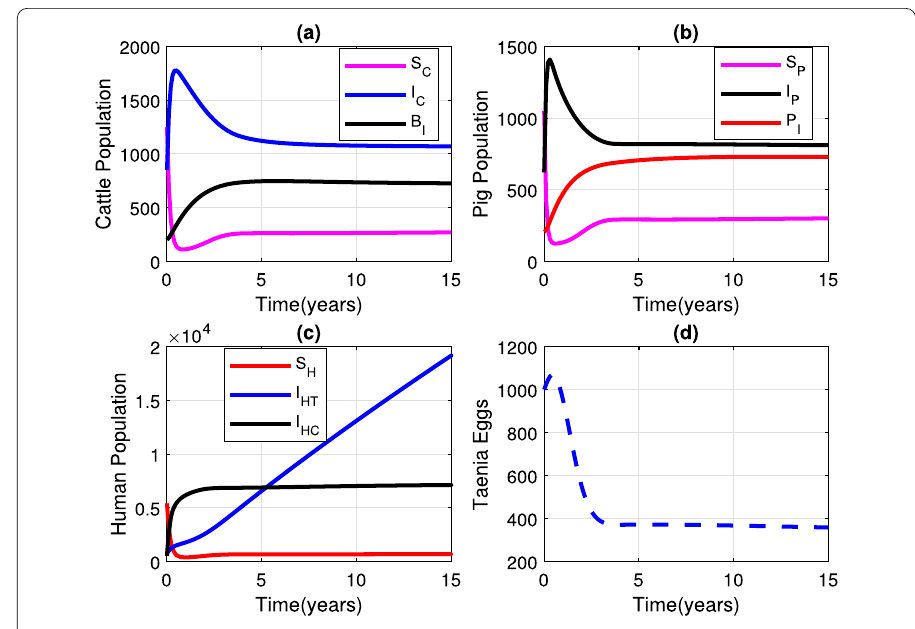
Figure 3 Dynamics of Humans, Pigs, Cattle and Taenia